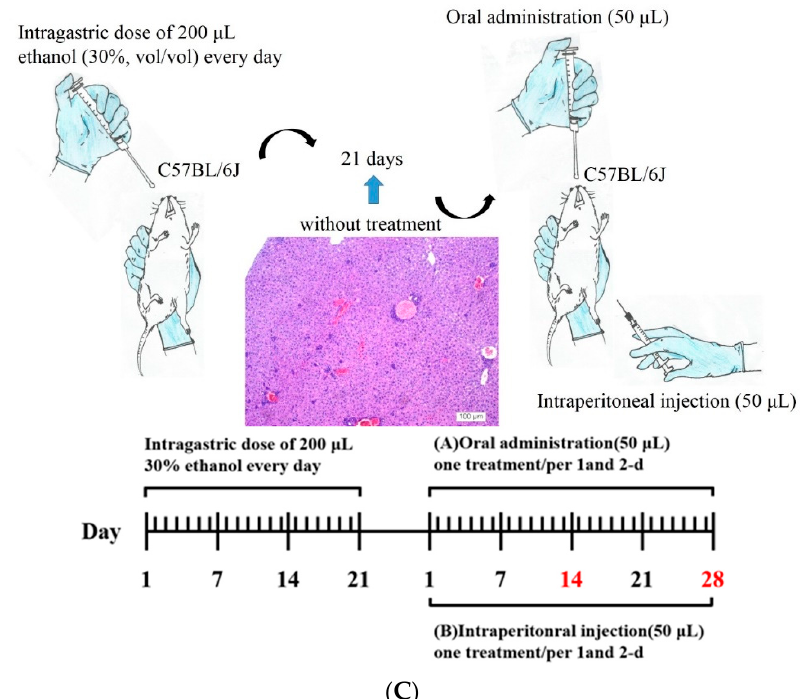
Figure 1. ( A ) Schematic of the Asta-lipo fabrication processes and the TEM images of the produced Asta-lipo. The TEM shows that the diameter of the fabricated Asta-lipo was approximately 225.0 ± 58.2 nm (mean ± SD). ( B ) Profile of Asta released from Asta-lipo ( N = 3, data are presented as the mean ± SEM by one-way analysis of variance (ANOVA)). ( C ) Schematic representation and time scale of the establishment of alcoholic disease and administration routes on the mouse model (scale bar: day).